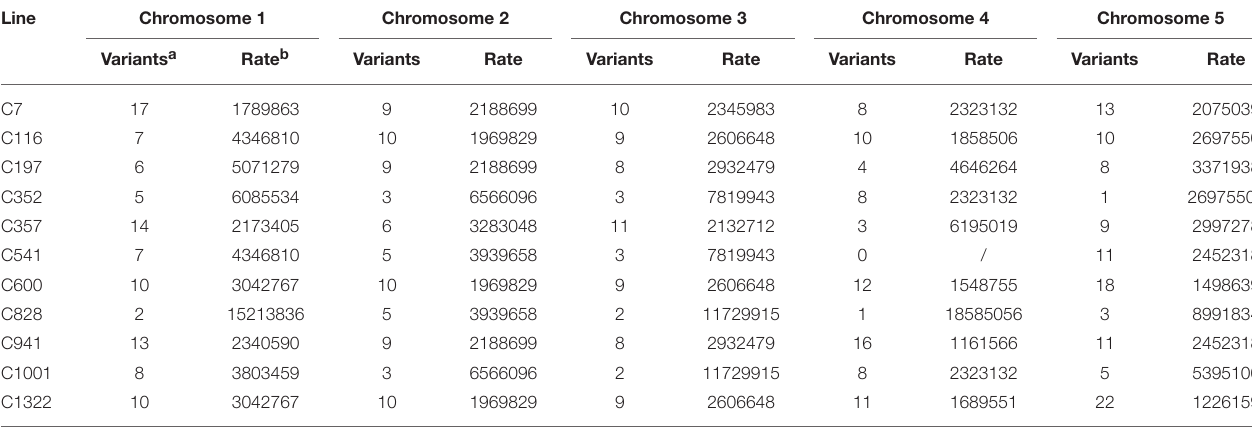
TABLE 1 | Variant rate of the single base substitutions and small INDELs across each chromosome in the 11 re-sequenced